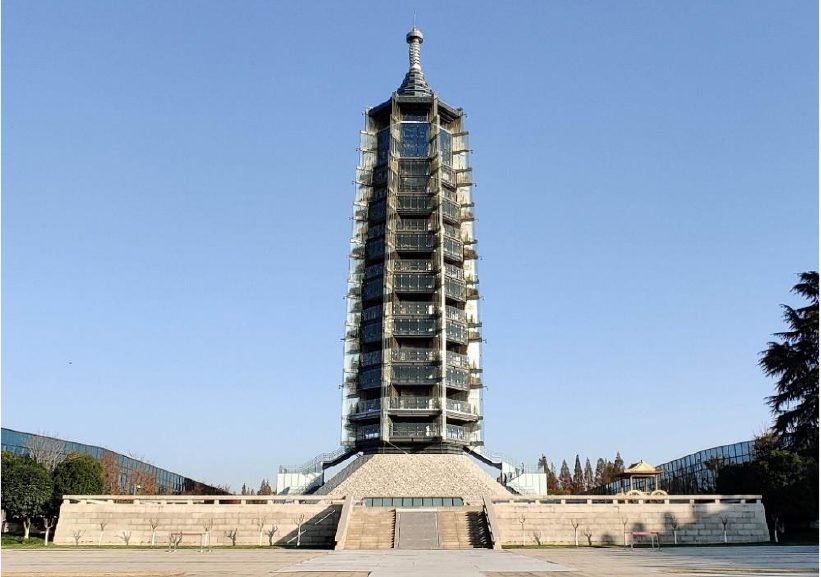
Figure 7. The overall appearance of the rebuilt Porcelain Tower (Source: photo courtesy of Pengfei Ma).